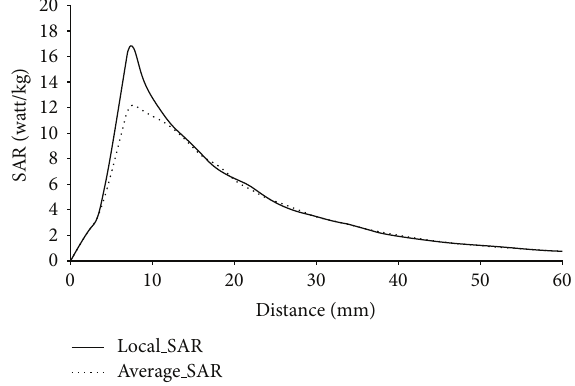
F 7: Head model as a function of the distance between the dipole and the head model.